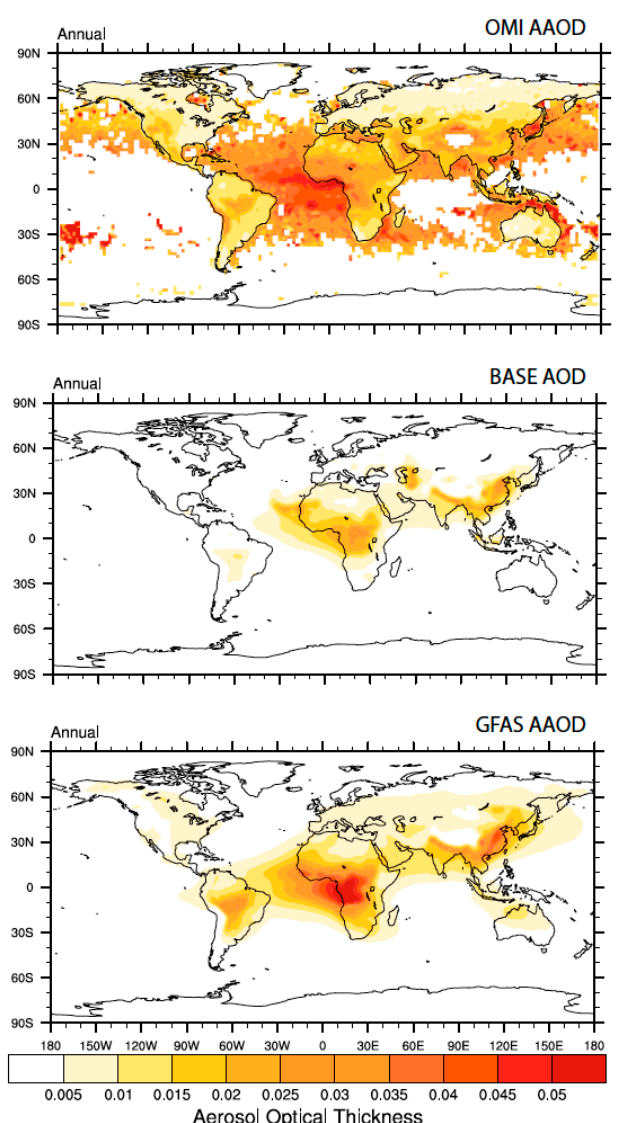
Figure 2. Annual average of the absorbing aerosol optical depth (AAOD) distribution. ( Top panel ) OMI AAOD satellite product at 500 nm, averaged for 2004 to 2010. ( Middle panel ) Eight-year annual average BASE simulation results for AAOD at 550 nm. ( Bottom panel ) Eight-year annual average GFAS simulation results for AAOD at 550 nm.